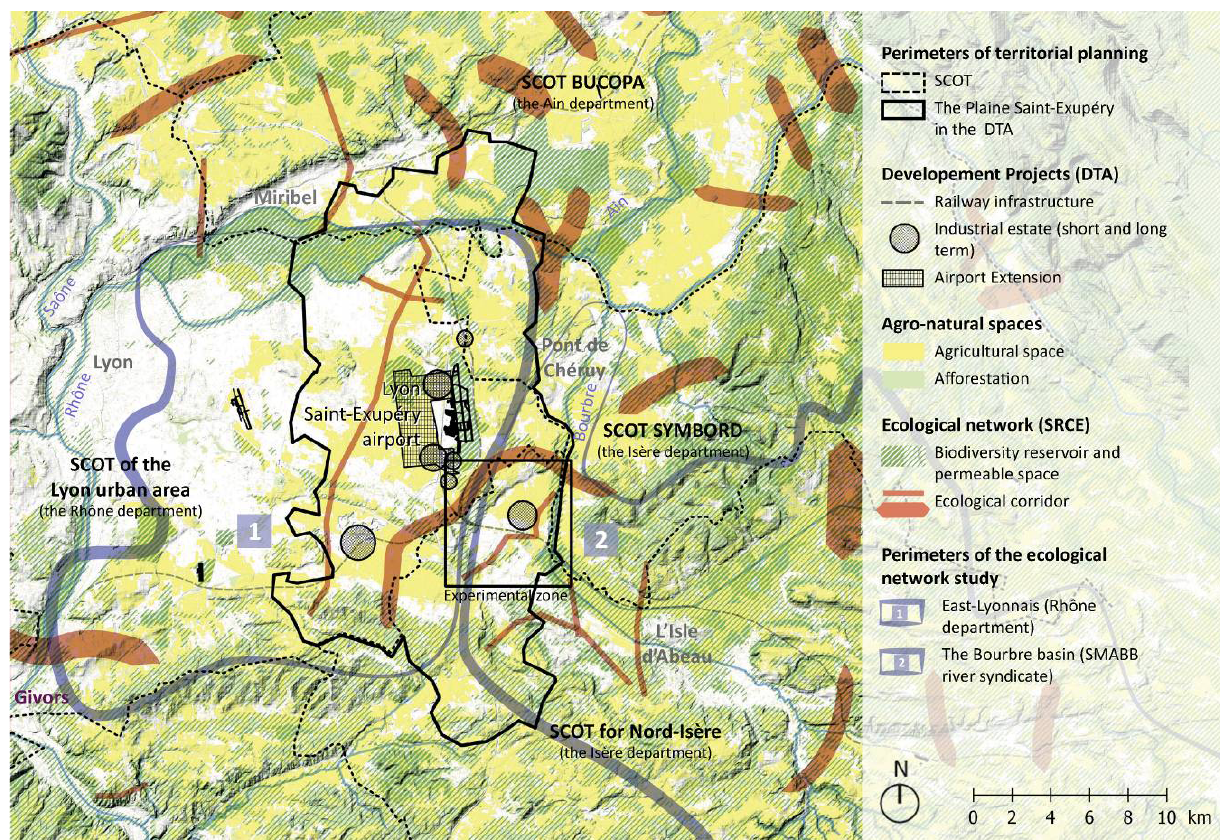
Figure 1. Plaine Saint-Exupéry: Perimeters for planning, ongoing projects and environmental challenges. Source: